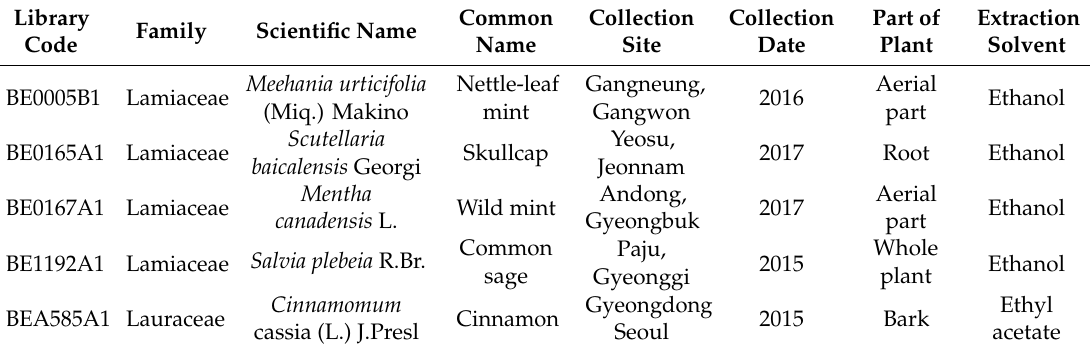
Table 1. Information on used plant extracts.